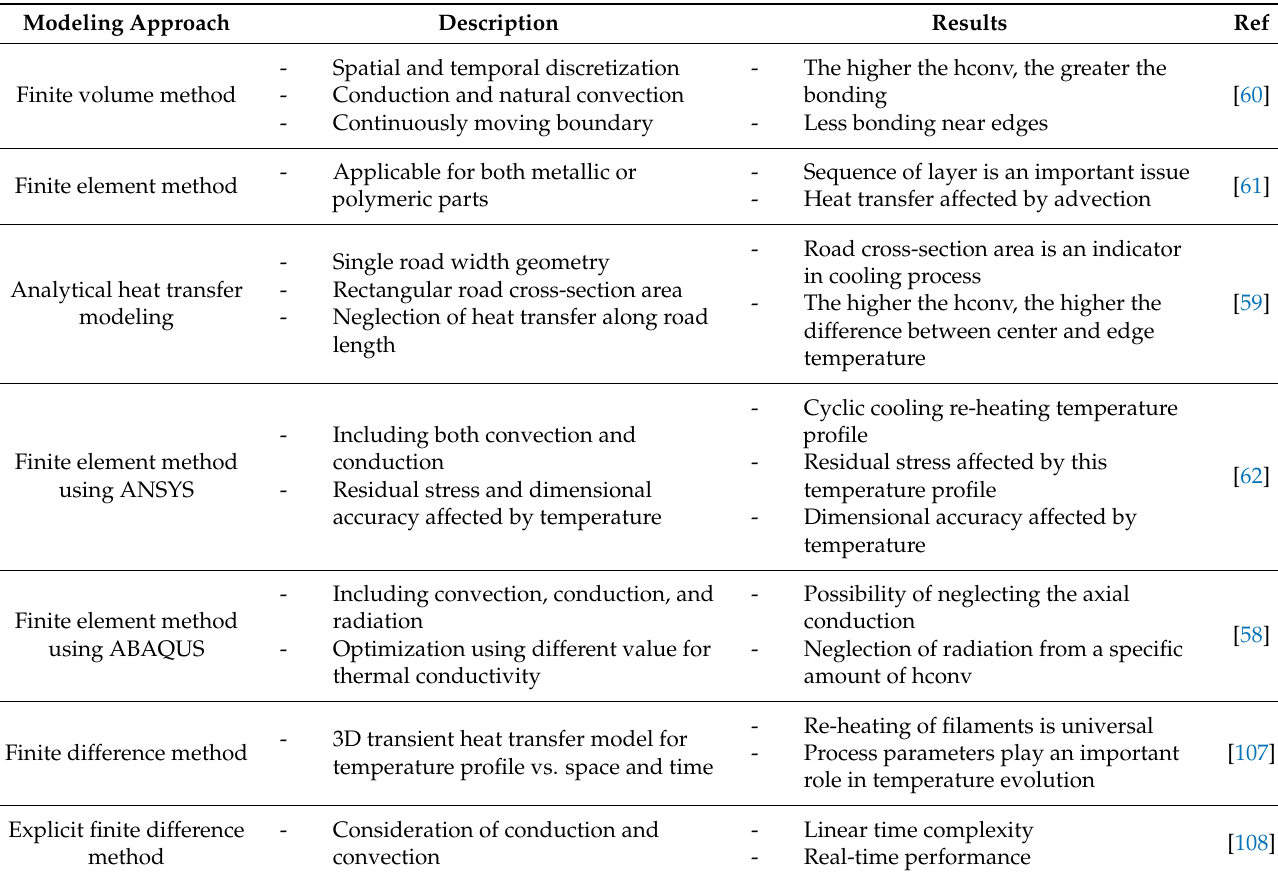
Table 1. Summary of the most attractive heat transfer modeling in